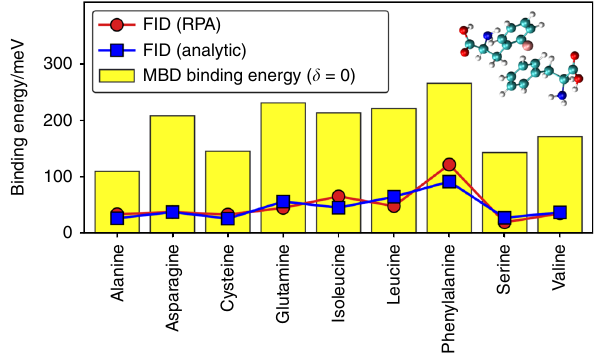
Fig. 5 Field-induced dispersion in amino-acid dimers. FID W bind c ð δ ¼ 1 Þ energy (in meV) obtained from RPA calculations (red line) and analytic Eq. (2) (blue line) compared with the MBD binding energy (yellow bars). The geometry of phenylalanine dimer and a point charge (in pink) is shown in the inset